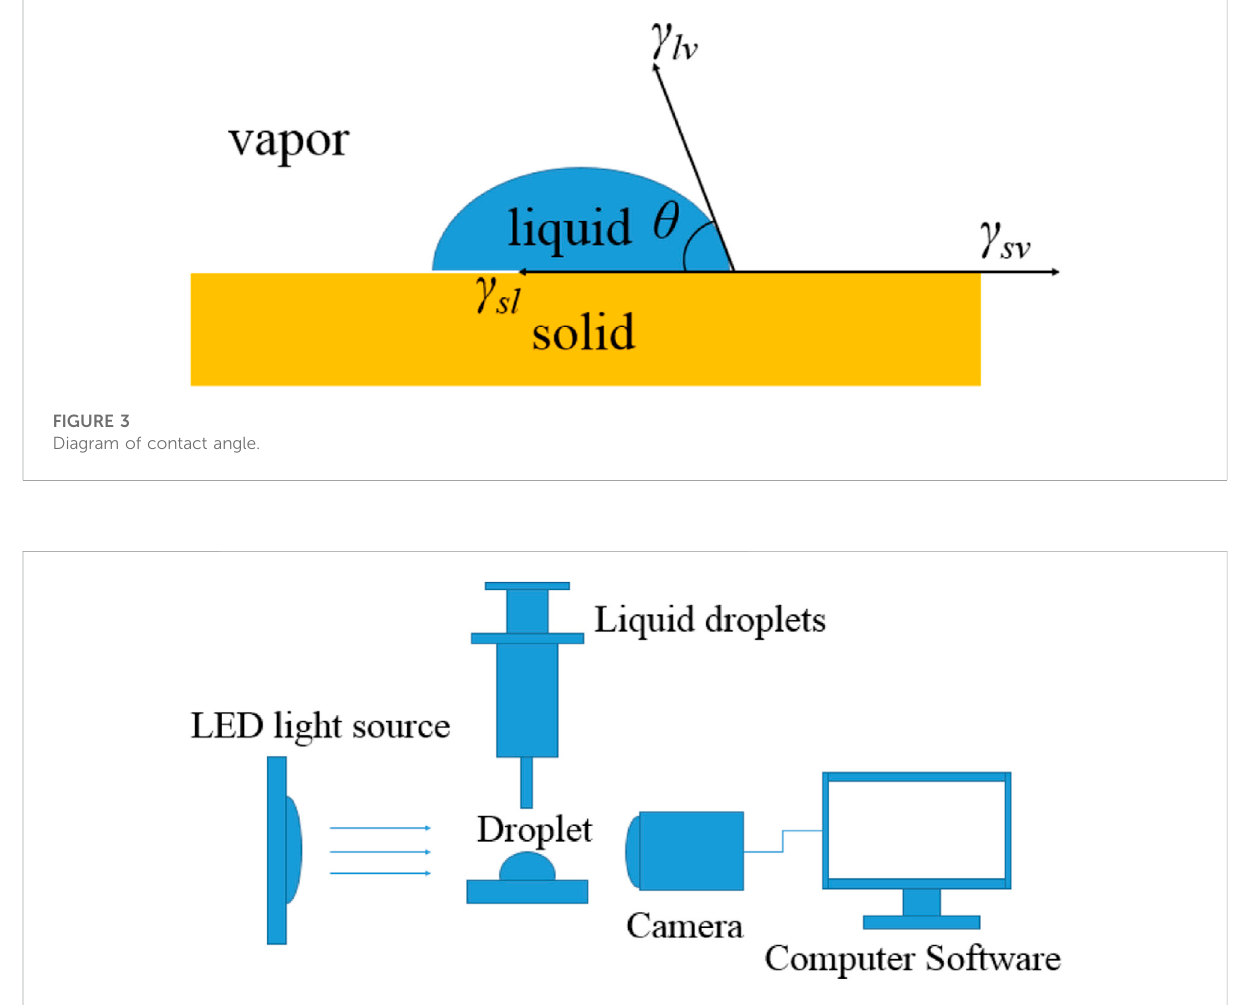
FIGURE 4 Principle of contact angle